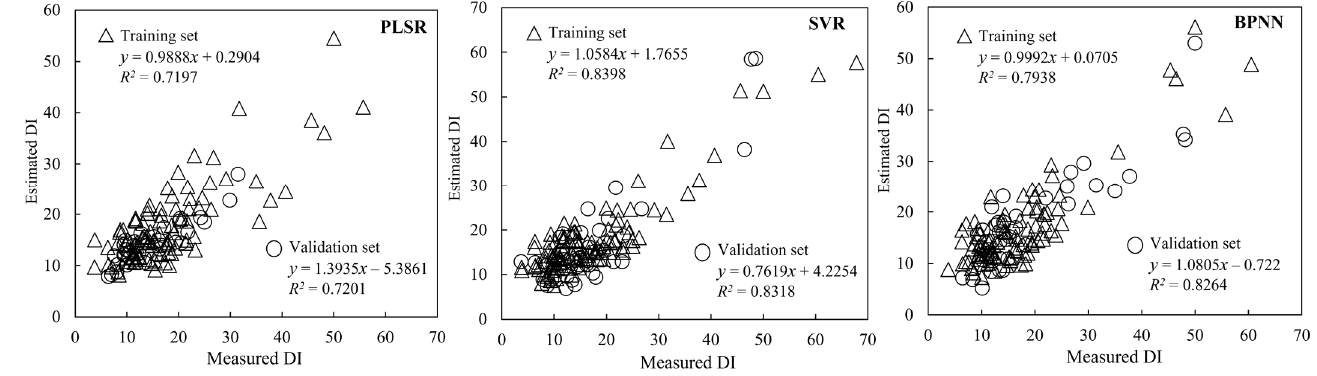
Figure 7. Comparison of monitoring accuracy of three algorithms.